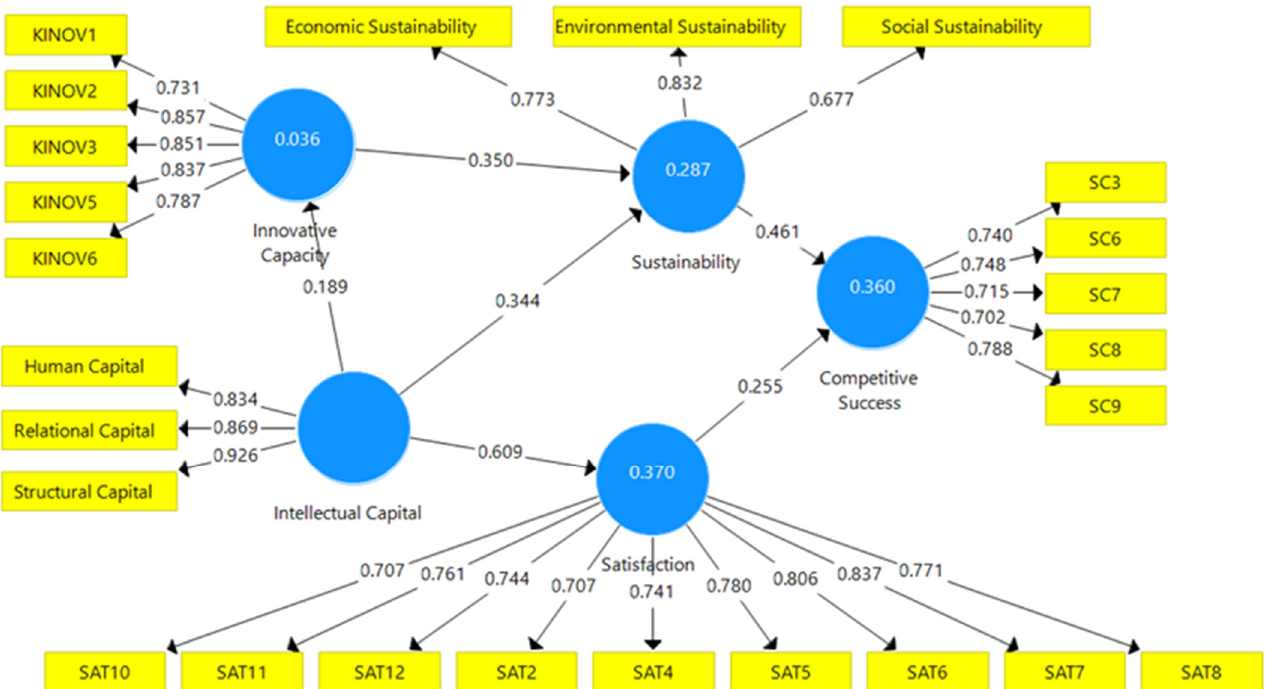
Figure 2. Measurement model. Source: prepared by the authors.